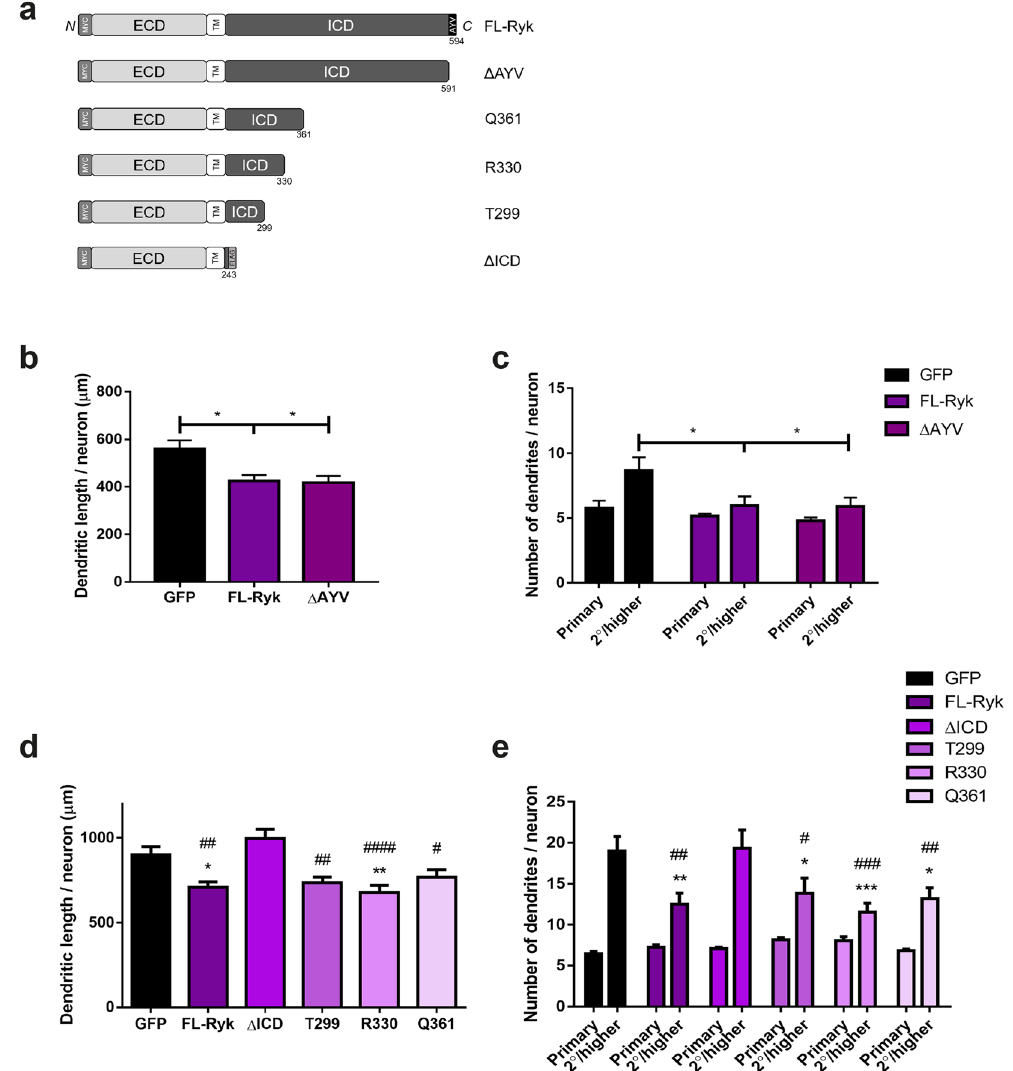
Figure 3. Ryk inhibits dendrite morphogenesis via its juxtamembrane domain. ( a ) Schematic diagram of FL- Ryk and truncation mutants. ( b , c ) Deletion of the Ryk PDZ-binding domain ( Δ AYV) inhibited dendrite growth and 2°/higher order branching to the same extent as FL-Ryk (n = 6; 50–60 neurons/condition; * p < 0.05). ( d , e ) Similarly, the truncation mutants T299, R330 and Q361 inhibited dendrite growth and 2°/higher order branching to the same extent as FL-Ryk (n = 6; 50–60 neurons/condition; * p < 0.05; ** p < 0.01; *** p < 0.001 compared to GFP alone). However, removal of the entire ICD ( Δ ICD) abrogated the ability of Ryk to suppress dendrite growth and 2°/higher order branching ( # p < 0.05; ## p < 0.01; ### p < 0.001; #### p < 0.0001). Data are represented as the mean ± s.e.m. ECD, extracellular domain; ICD, intracellular domain; TM, transmembrane